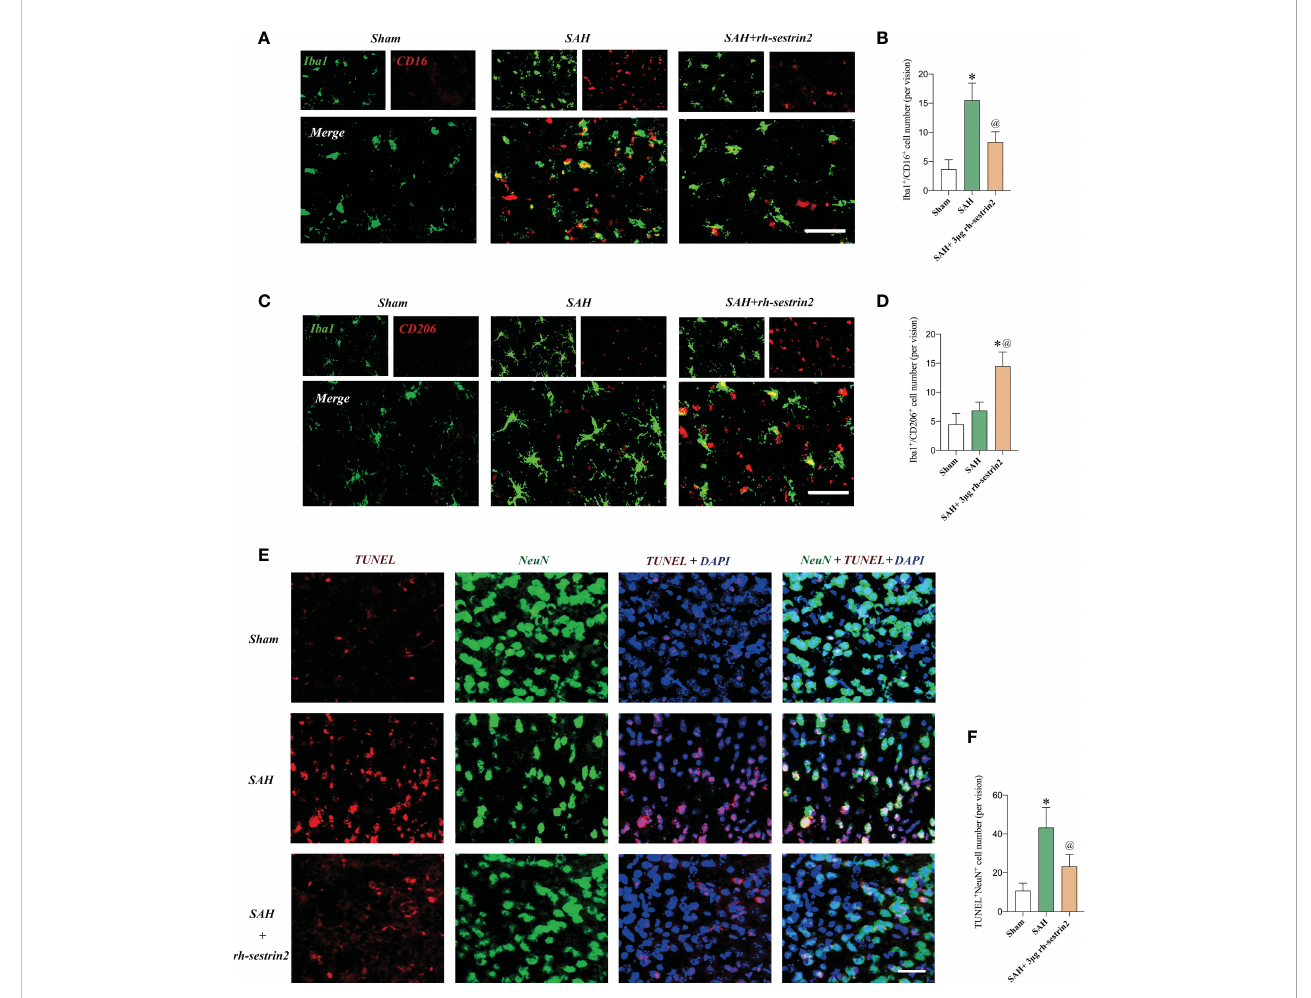
FIGURE 3 Rh-sestrin2 inhibited M1 microglia, increased M2 microglia polarization, and reduced neuronal apoptosis after SAH. (A) Representative images and (B) quanti fi cations of CD16 + /Iba1 + staining in different groups (n = 6 per group). (C) Representative images and (D) quanti fi cations of CD206 + /Iba1 + staining in different groups (n = 6 per group). (E) Representative images and (F) quanti fi cations of TUNEL staining in different groups (n = 6 per group). * P < 0.05 versus sham group. @ P < 0.05 versus SAH group. Data indicated as mean ± SD. Scale bars = 50 m